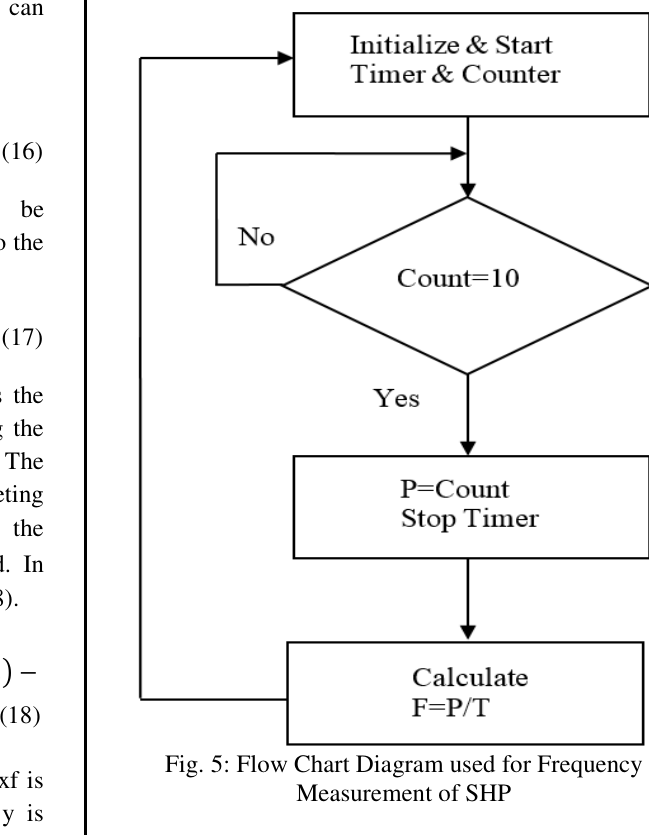
Fig. 5: Flow Chart Diagram used for Frequency Measurement of